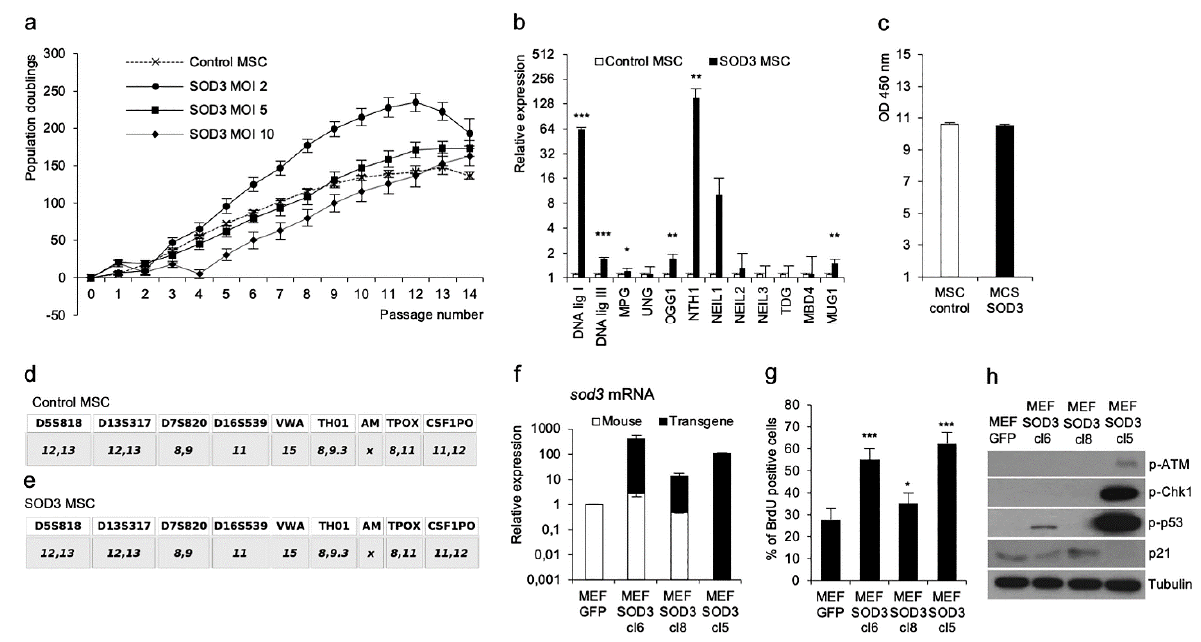
Figure 1. SOD3 stimulates growth without causing long-term DNA aberrations. ( a ) Dose-dependent effect of SOD3 on human MSC growth. Passage number analysis demonstrated increased cell proliferation at low MOI and decreased growth at high MOI. ( b ) DNA damage correction enzyme expression analysis of GFP and SOD3 MSCs from passage 1.